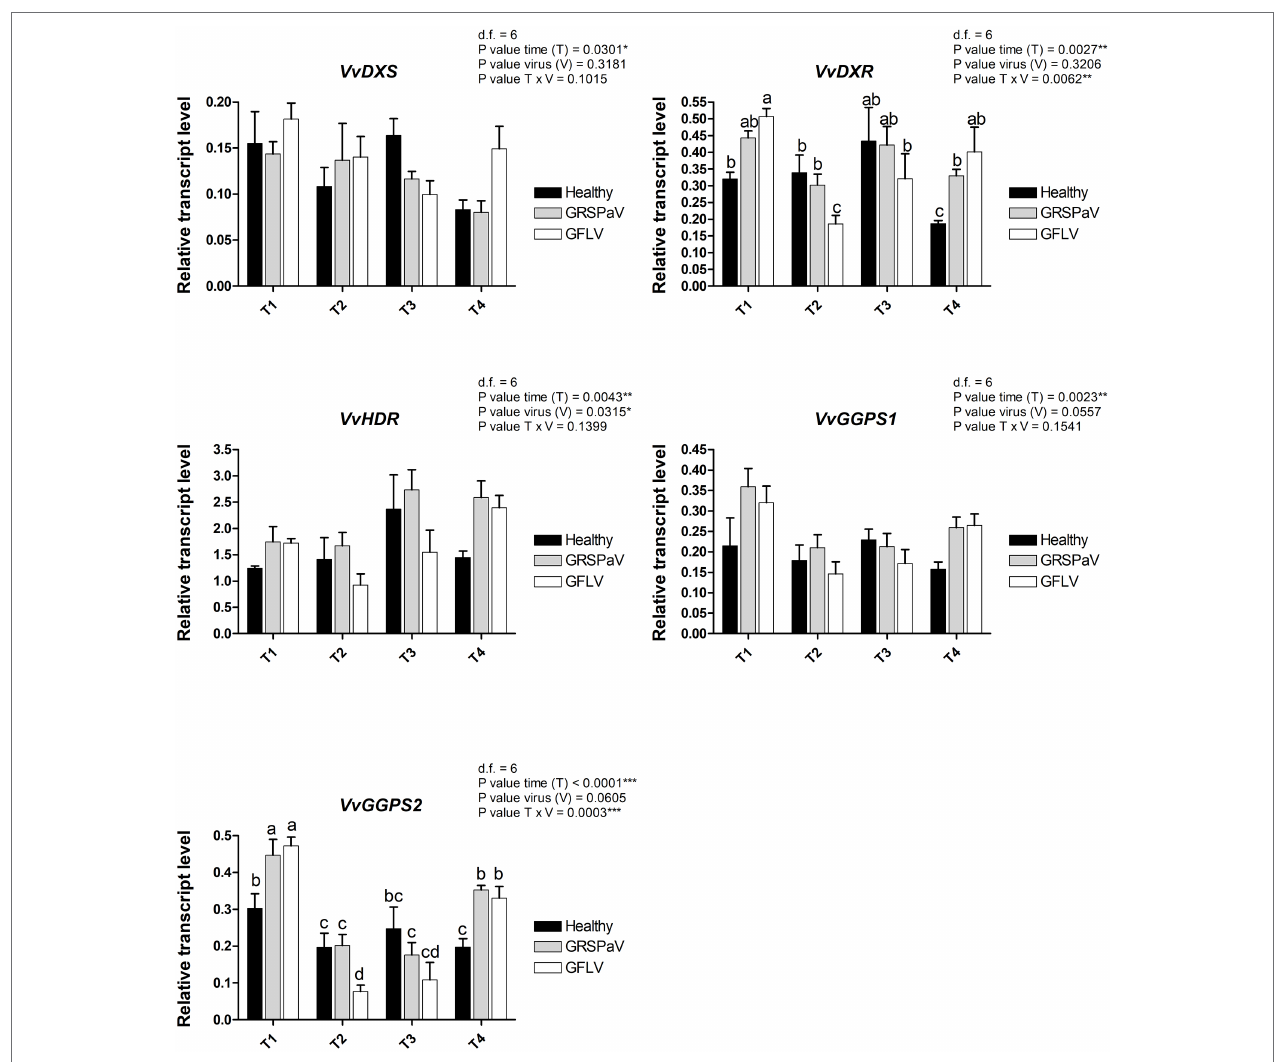
FIGURE 7 | Relative expression levels of VvDXS (VIT_05s0020g02130), VvDXR (VIT_17s0000g08390), VvHDR (VIT_03s0063g02030), VvGGPS1 (VIT_04s0023g01210), and VvGGPS2 (VIT_18s0001g12000), measured by RT-qPCR. Samples were collected in four sampling points along the season (May_T1, June_T2, July_T3, and August_T4). RT-qPCR signals were normalized to VvAct and VvUBI transcripts. Data are presented as the mean ± SE ( n = 4). Significance of sampling time, virus, and time x virus (T × V) interaction was assessed by Tukey’s HSD test for p ≤ 0.05 (*), p ≤ 0.01 (**), p ≤ 0.001 (***) and the corresponding results are given above each graph in the figure panel. Lower case letters above bars are reported when the T × V interaction are statistically significant as attested by Tukey’s